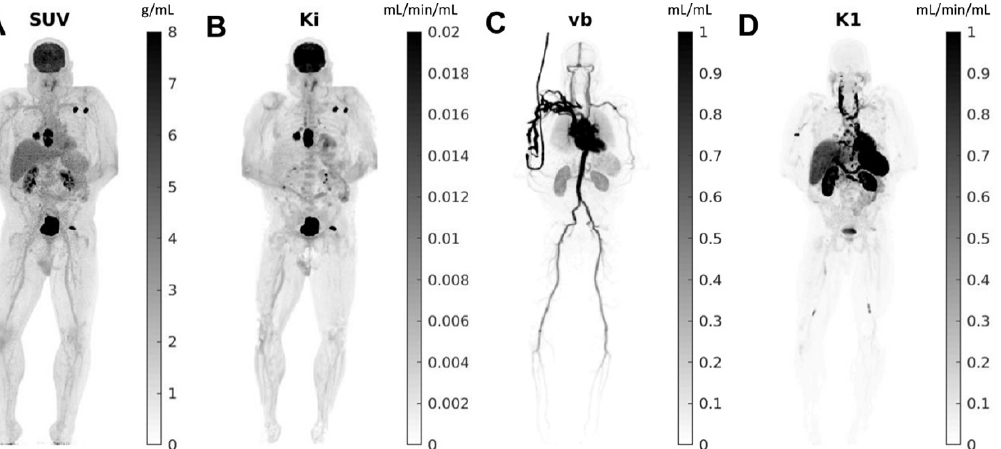
Figure 2. Total-body parametric images estimated from a 60-min dynamic 18 F-FDG scan of a patient with metastatic cancer on the uEXPLORER: ( A ) SUV; ( B ) FDG net influx rate (Ki); ( C ) fractional blood volume (vb); and ( D ) FDG delivery rate (K 1 ). Reprinted with permission from Ref. [19]. Copyright 2021 Elsevier.